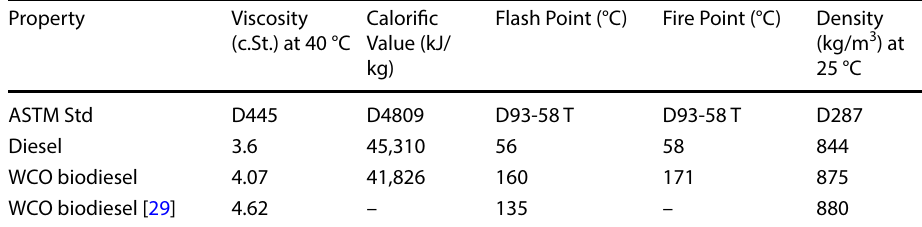
Table 1 Chart representing ASTM standard